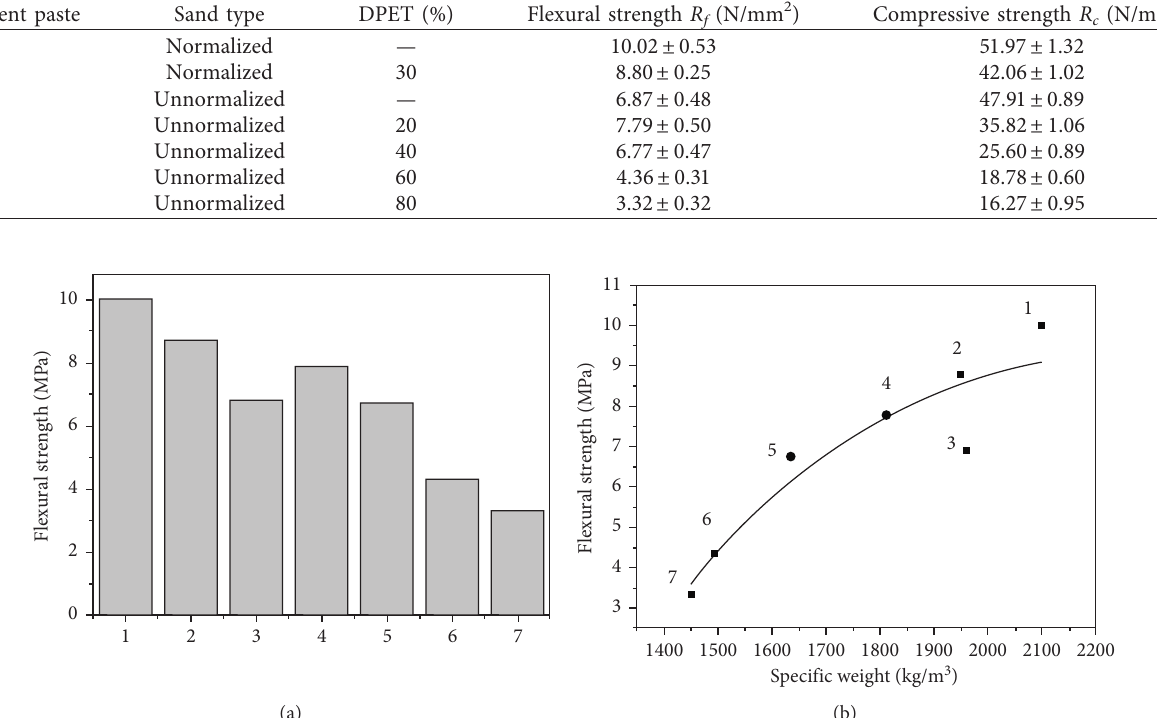
Figure 8: (a) Flexural strength according to tested mixture type; (b) relationship between the flexural strength and specific weight of the